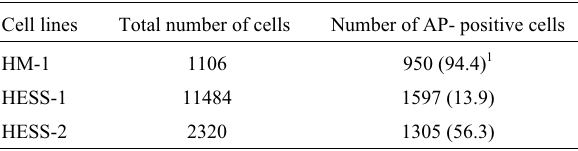
Table III - Percentage of alkaline phosphatase positive cells in undiffer- entiated cultures of HM-1 cells and their